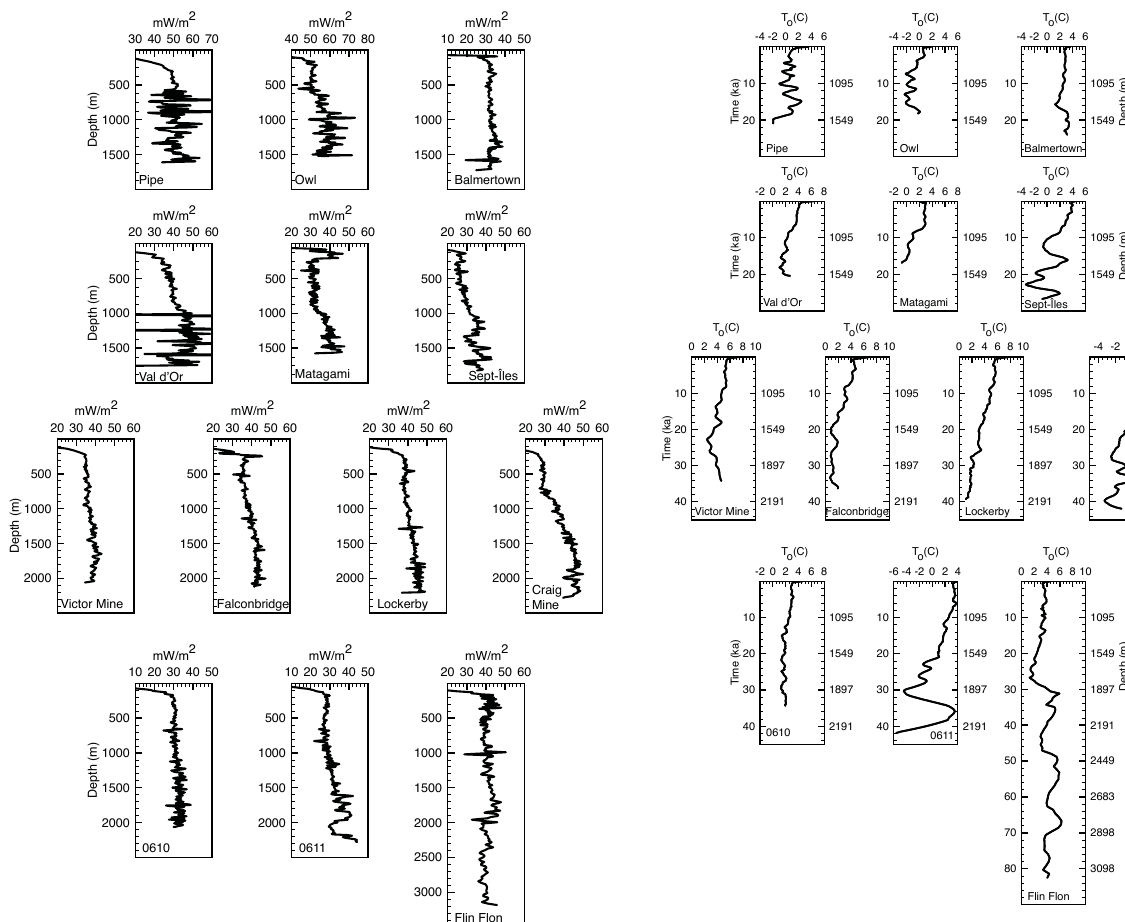
Figure 3. Long-term surface temperature variations over time (left y axis) and depth (right y axis) for all the boreholes. Time is deter- mined from depth by Eq.